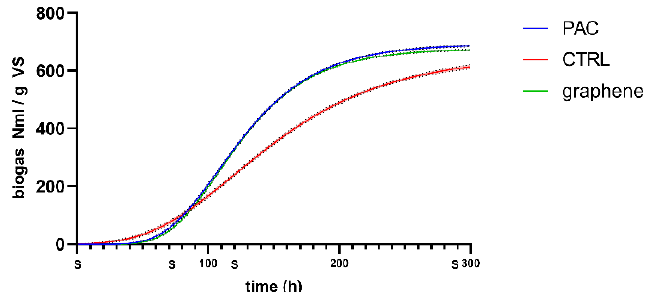
Figure 4. Predicted values as per Gompertz fitting of cumulative biogas production for the reactors added with graphene and PAC separately. CTRL is the control without any material addition. Data are normalized on the organic matter added as volatile solids (VS). S on the x -axis corresponds to a sampling time for molecular microbial community analysis (CI 95%).